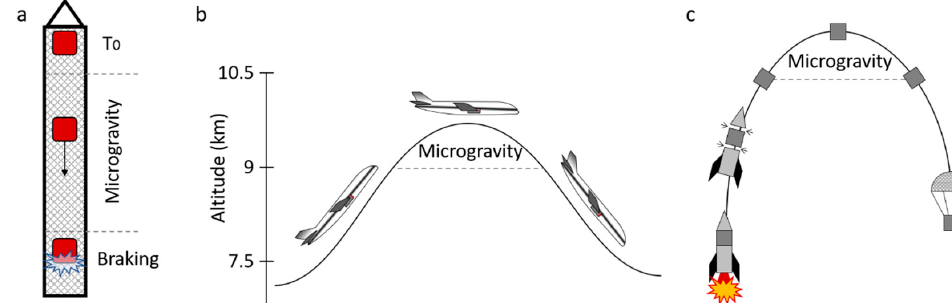
Figure 3. Non-orbiting microgravity facilities. Schematic representation of ( a ) drop tower; ( b ) parabolic flight; and ( c ) sounding rocket. As microgravity can only be achieved transiently, these facilities are widely used for short-term experiments.